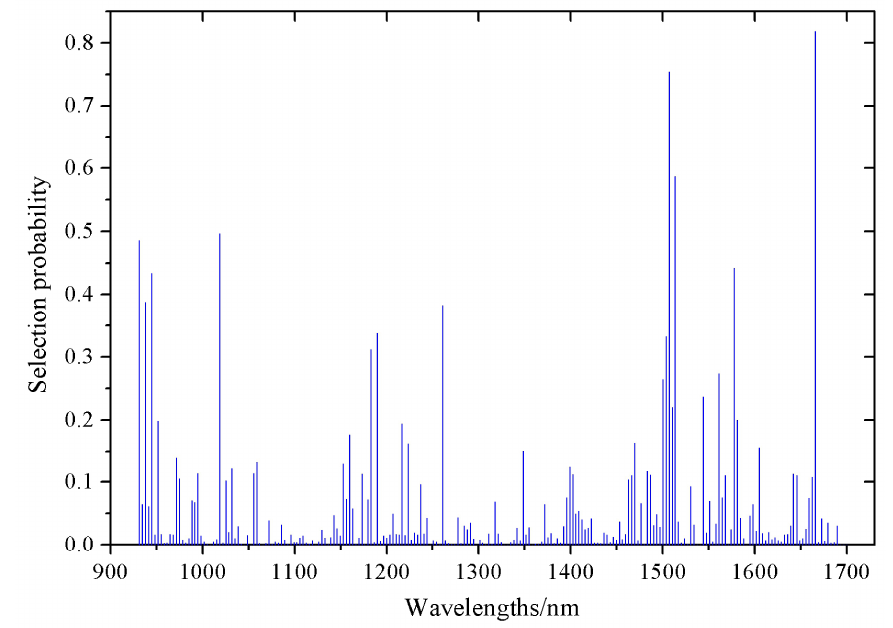
Figure 8. Selection probability (SP) of each wavelength averaged over 50 runs of the random frog (RF) algorithm. Table 2. The effective wavelengths selected by X-loading, SPA, and RF for differentiating between the roasting degrees of the coffee beans.